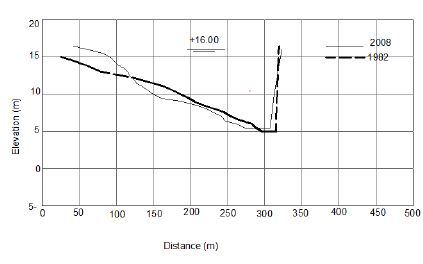
Figure 14. Cross section No.5